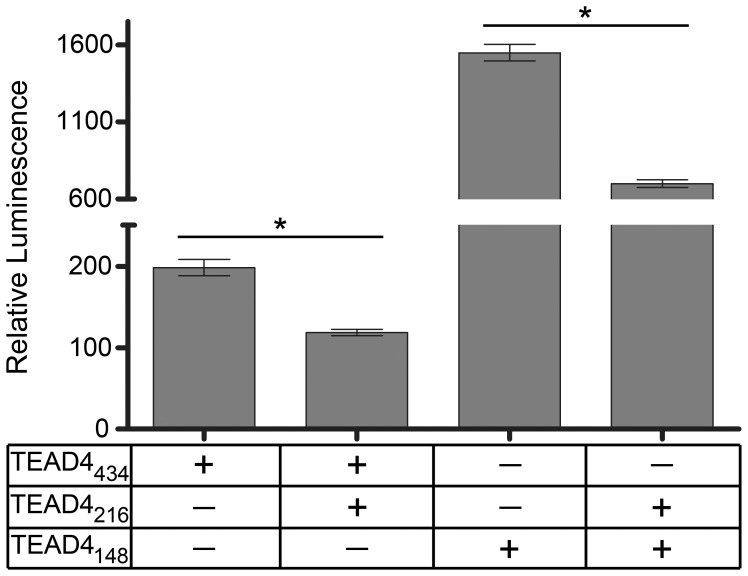
The TEAD4216 isoform can competitively inhibit promoter activity.The TEAD4216 isoform can competitively repress expression from the human VEGF promoter in the presence of either the TEAD4434 or TEAD4148 enhancer isoforms (p<0.005, n = 6).